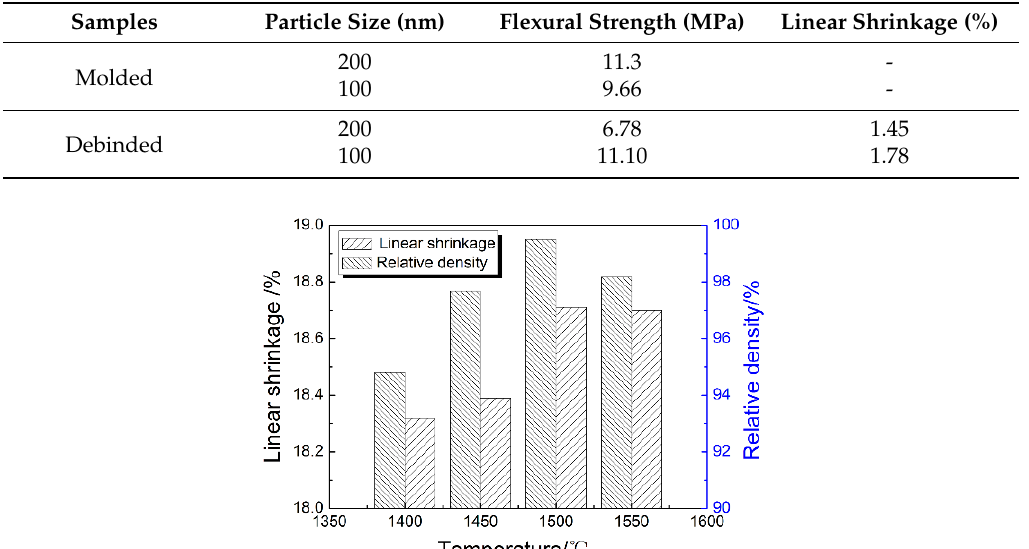
Figure 6. SEM morphology of debound ZrO 2 samples using different powders: ( a ) 200 nm; ( b ) 100 nm. Table 3. Flexural strength and linear shrinkage of the different samples after molding and debinding.